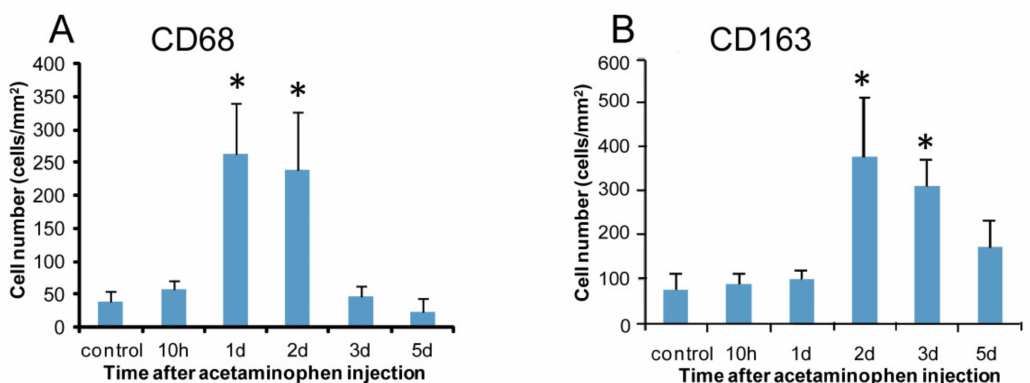
Figure 4. Kinetics of macrophages reacting to CD68 and CD163. Compared to the controls, the numbers of cells expressing CD68 ( A ) on days 1 and 2 and CD163 ( B ) on days 2–3 increase significantly. Dunnett’s test; *, significantly di ff erent from controls at p < 0.05. Bar represents mean ±